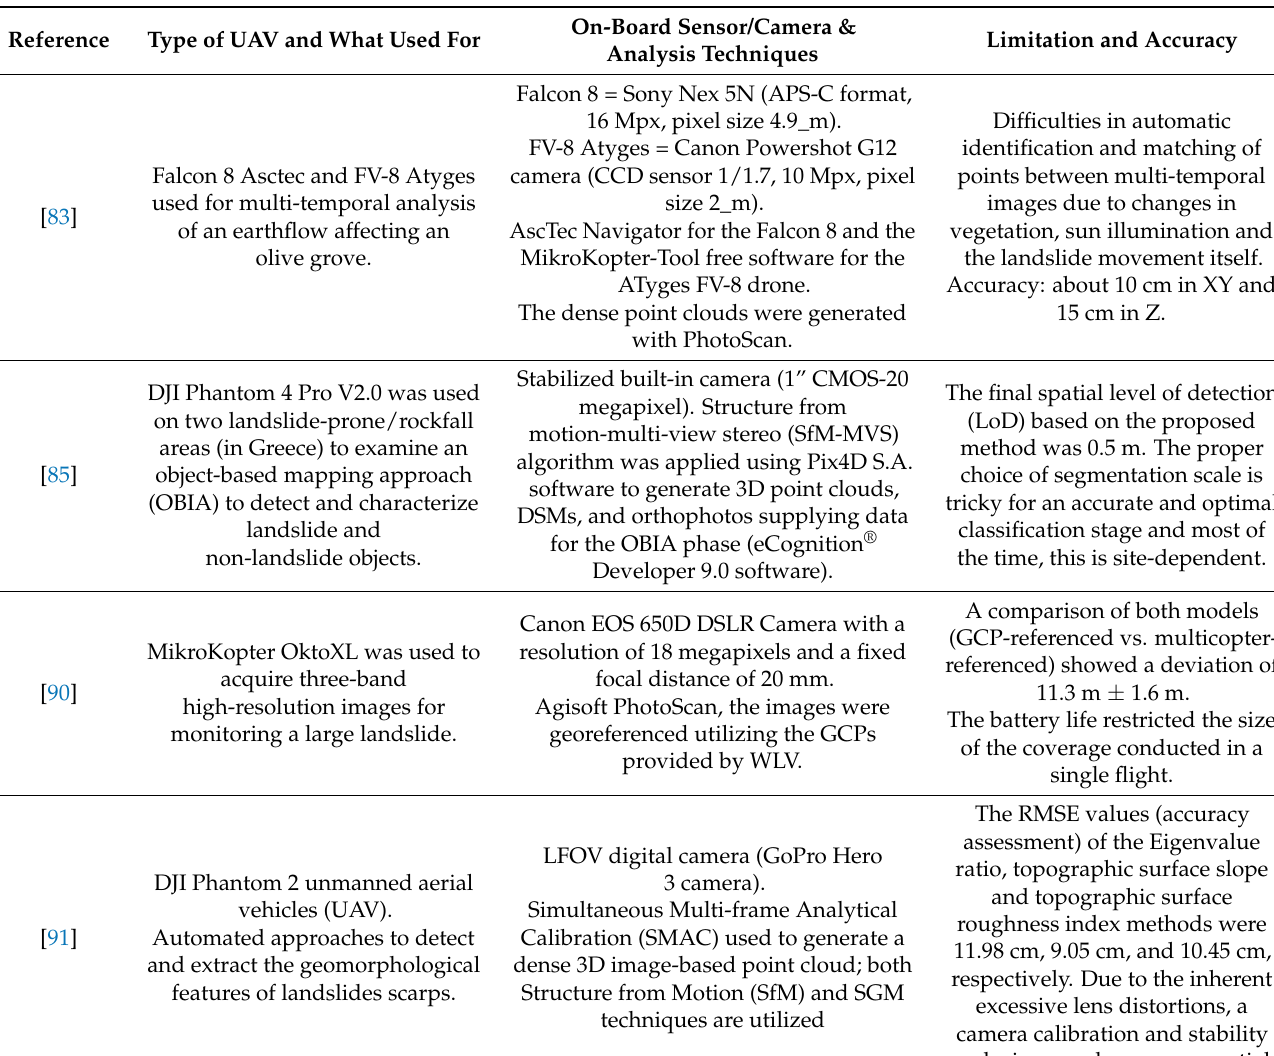
Figure 4. Summary of airborne systems used for landslide mapping according to the sensor types, possible processing techniques and available outputs. Table 2. Recent landslide studies that adopted UAV-based